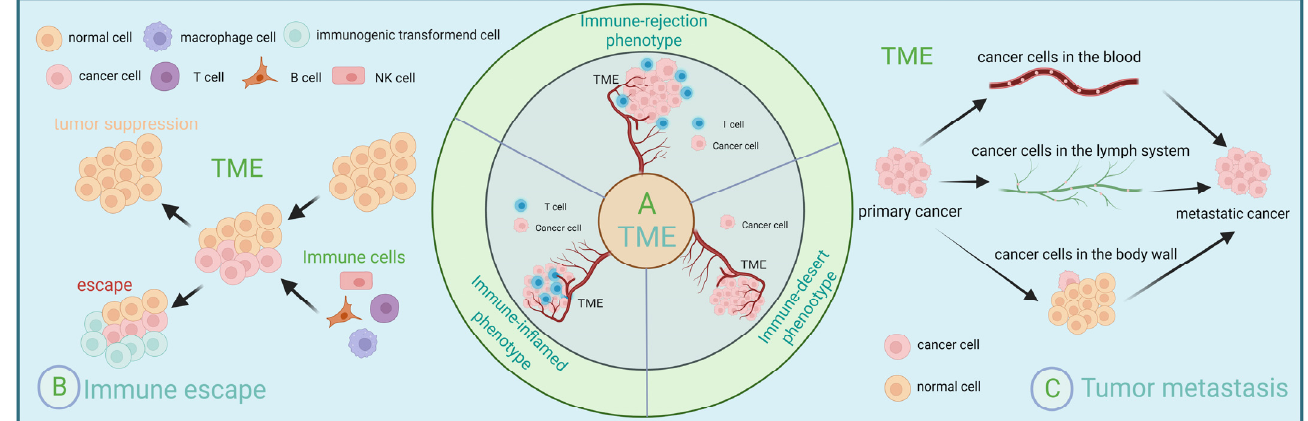
Figure 1. Immunoregulation and tumor microenvironment. ( A ) Depending on the number and spatial distribution of T cells, the tumor microenvironment can be divided into three types: immune inflammatory, immune rejection, and immune desert. ( B ) Schematic representation of immune evasion within the tumor microenvironment. ( C ) Three ways of tumor metastasis: lymphatic metastasis, hematogenous metastasis, and implantation metastasis.